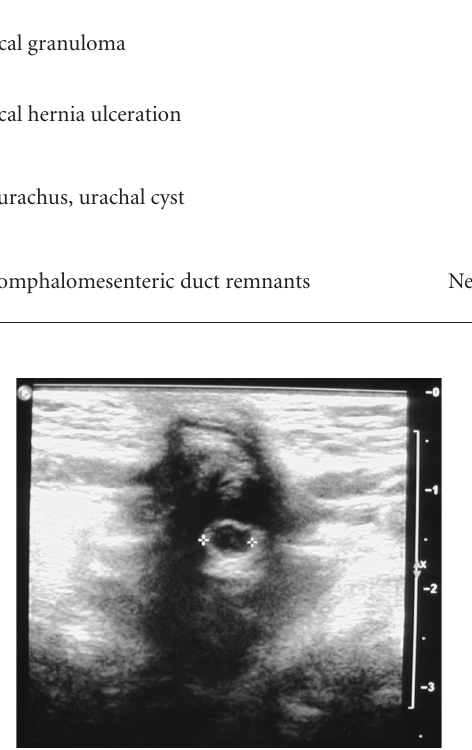
Figure 1: Umbilical cyst visualized by ultrasound through the anterior abdominal wall.